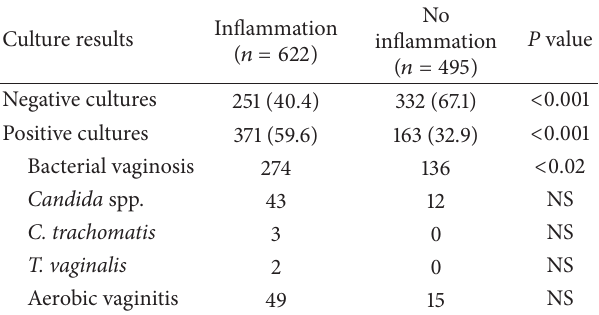
Table 1: Culture results in study groups. Figures are numbers